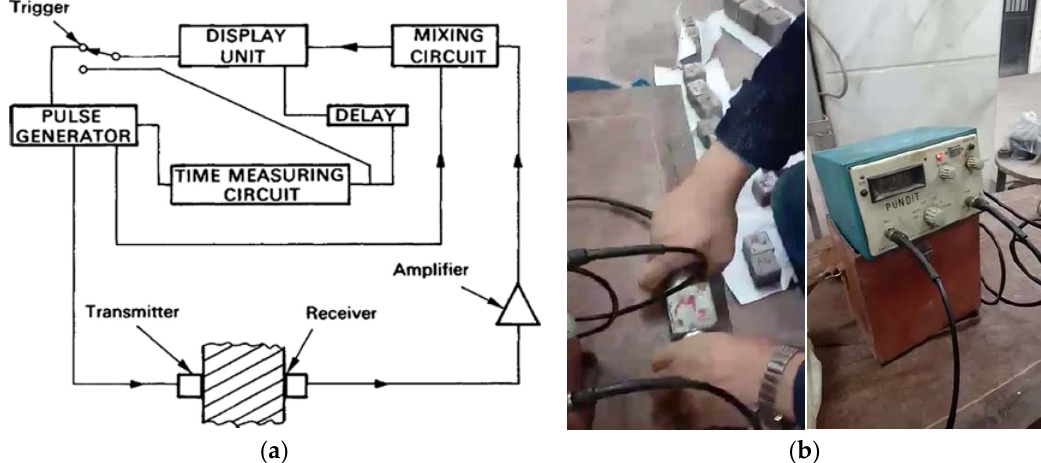
Figure 6. Ultrasonic pulse velocity (UPV) testing process. ( a ) UPV circuit components [35]; ( b ) UPV applying direct method.